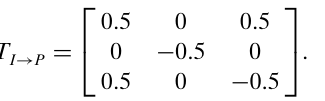
Figure 11 Preliminary structure for SAXDUR using the I -centred supercell: ( a ) Initial SHELXD solution (using two twin components). ( b ) After model building and isotropic refinement. ( c ) With anisotropic displacement parameters and riding methyl hydrogens (four twin components). Diagrams generated using ShelXle (Hu¨bschle et al. , 2011).